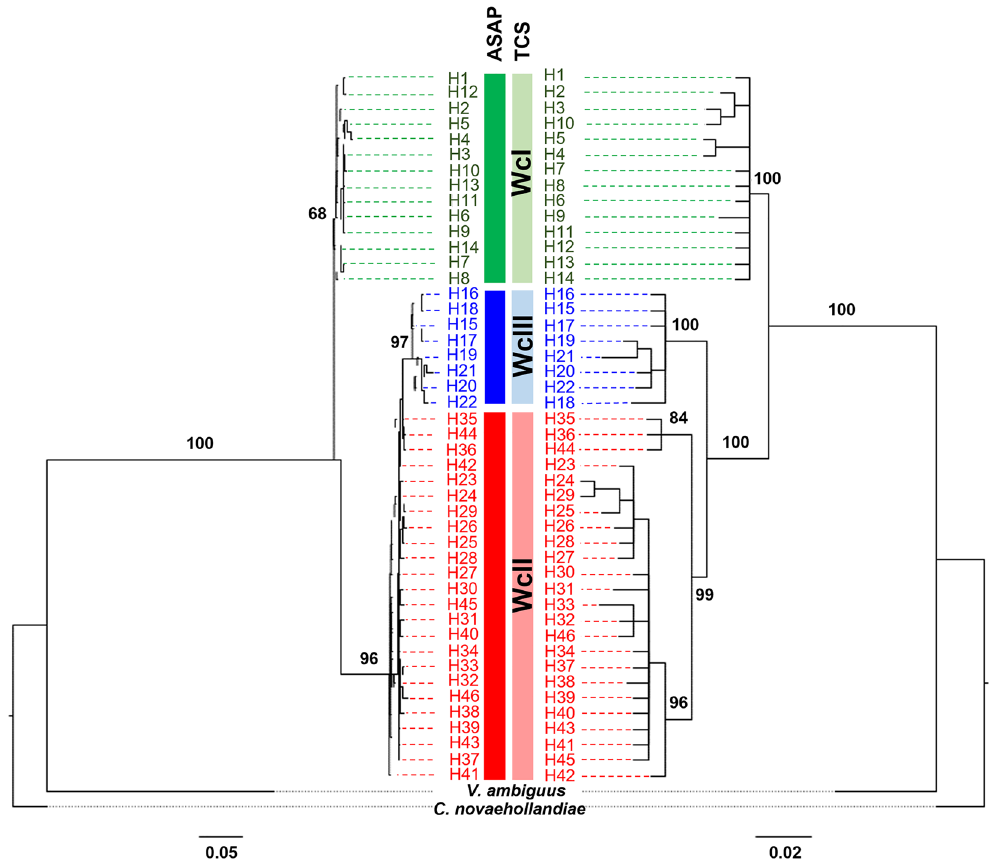
Figure 1. Phylogenetic trees obtained by maximum likelihood (left) and Bayesian inference (right) analysis of “ Westralunio carteri ” mtDNA COI sequences, including support values for the major genetic clades [ultrafast bootstrap values (left) and Bayesian posterior probabilities (right)]. Colour coded bars show support for the three major clades by the species delimitation methods (ASAP = dark shade; TCS = lighter shade). Green = WcI = “ W. carteri ” I; blue = WcIII = “ W. carteri ” III; red = WcII = “ W. carteri ” II. Results of bPTP analysis not shown (see supplementary data). Haplotype names correspond to Benson et al. 28 . Outgroup taxa are